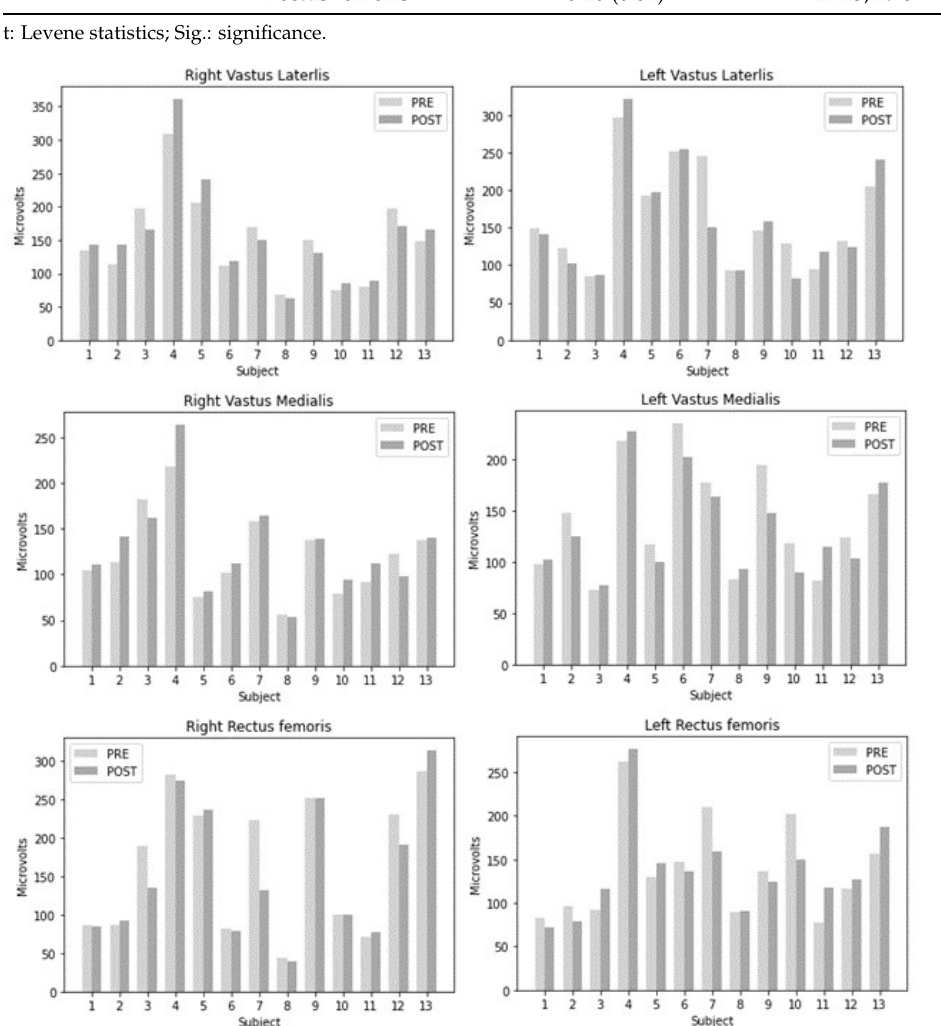
Figure 1. Changes in root mean square after intervention.